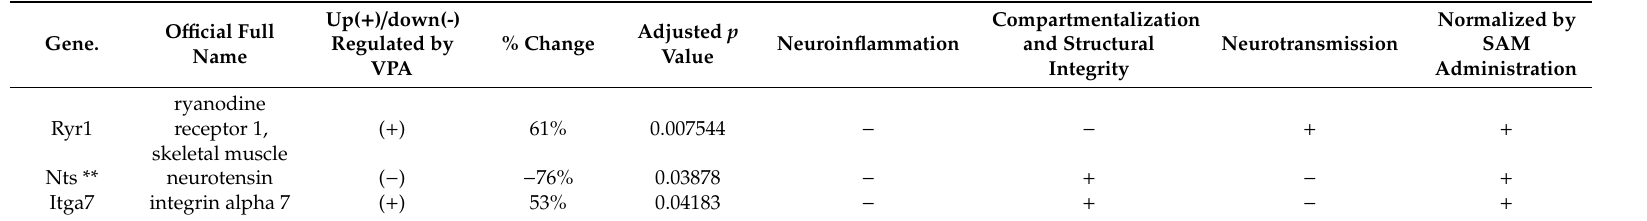
Table 3. Genes changed by VPA at least by 50% in males and the normalization by SAM *.